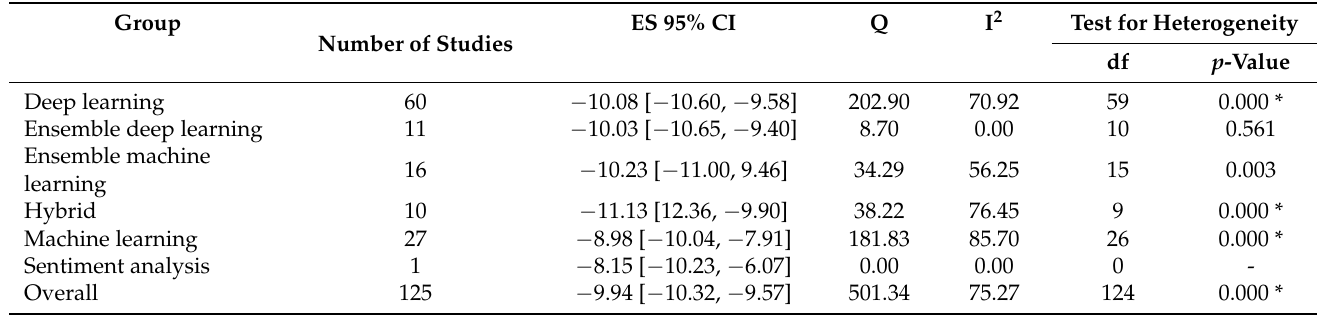
Table 4. Subgroup analysis for the comparison of different approaches.